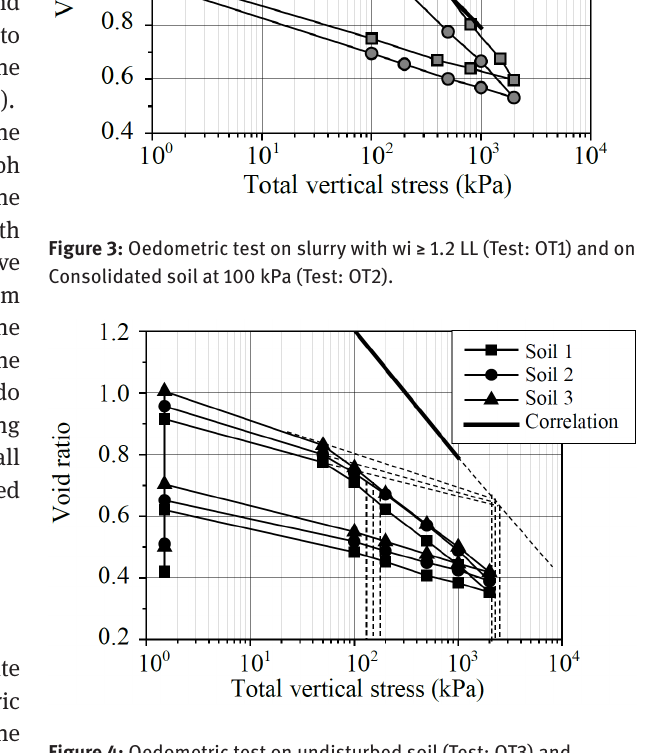
Figure 4: Oedometric test on undisturbed soil (Test: OT3) and extrapolation of correlation line and oedometric